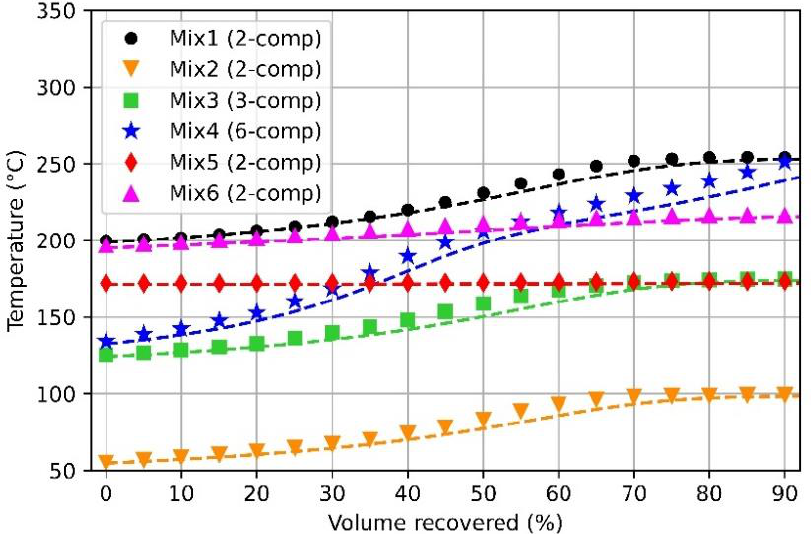
Figure 2. Experimental (markers) and predicted (dashed lines) distillation curves (kettle tempera- tures) for six validation mixtures of known composition from literature.